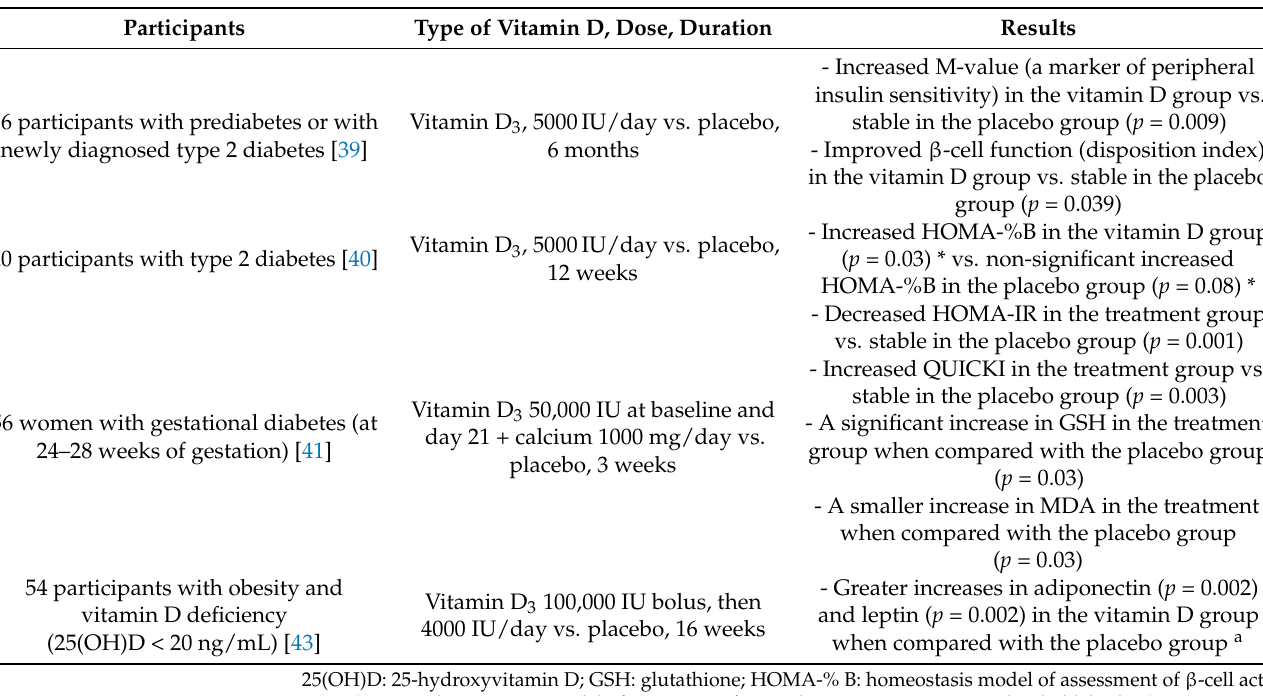
Table 2. Effects of vitamin D supplementation on β -cell function, insulin sensitivity, and adipokines related to energy homeostasis in